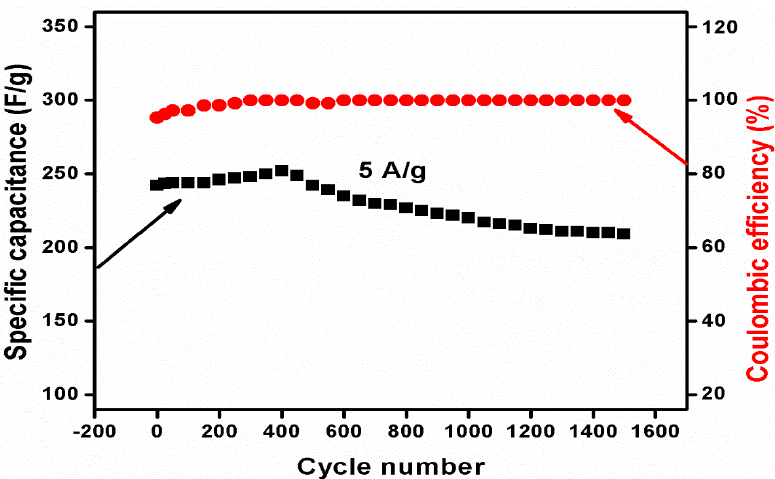
Figure 7. SC and coulombic efficiency vs. cycle number for the CWO–Ni3 electrode material for supercapacitor applications.